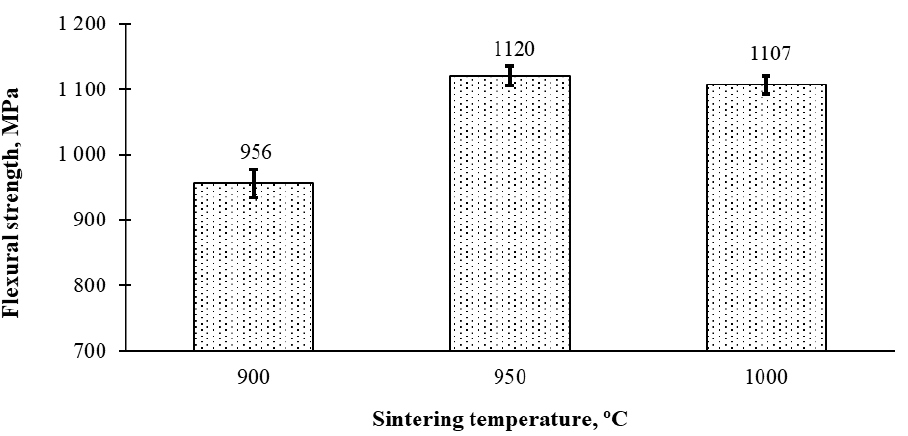
Figure 6. Flexural strength of spark plasma sintered M3/2–50% Fe materials.